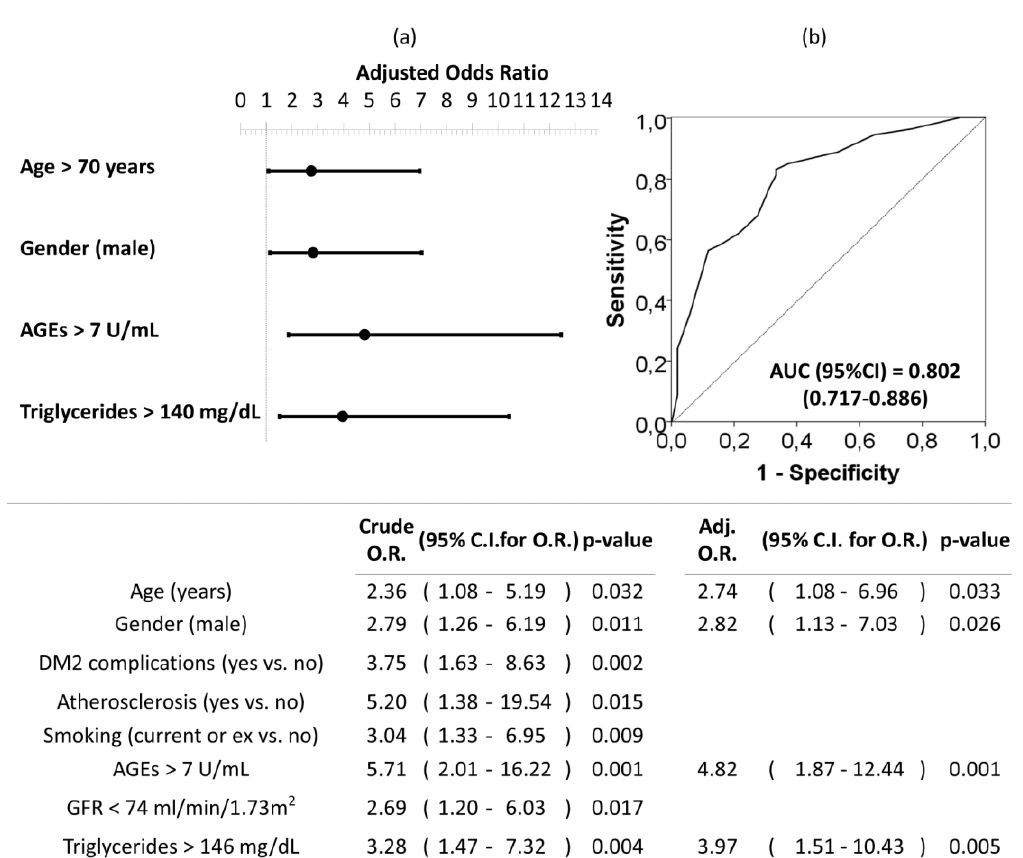
Figure 4. Forest plot ( a ) and ROC curve ( b ) of the multivariate logistic regression of risk factors associated to moderate–severe AAC in patients with DM2. Multivariate analysis was performed using stepwise backward method. Crude and adjusted odds ratio (OR) are indicated in the table. Comparison of the expected and observed frequencies by the Hosmer–Lemeshow goodness-of-fit test ( p -value = 0.734) and by ROC curve (AUC = 0.802; p < 0.001) indicated a good fit for the model. AUC = the area under the curve, GFR = glomerular filtration rate.